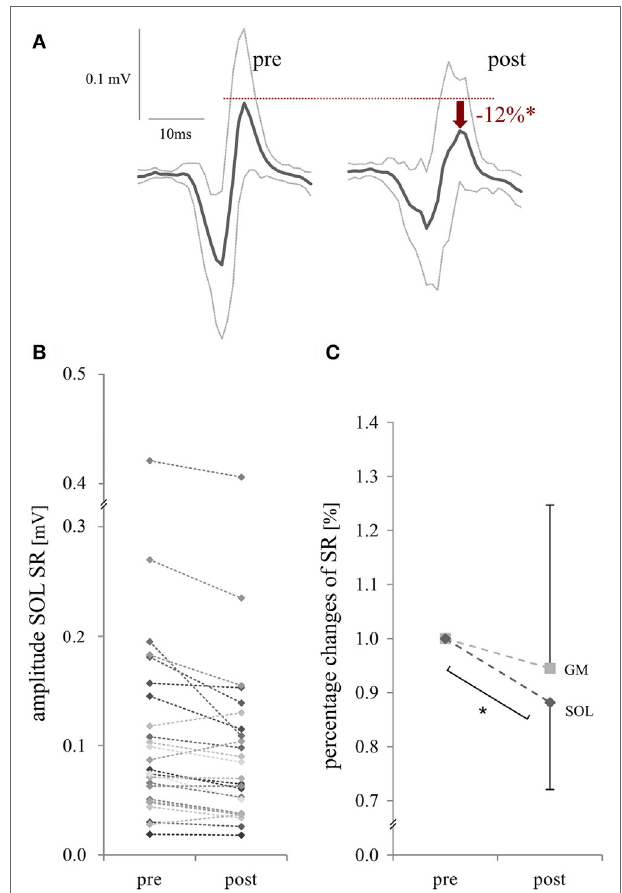
FigUre 3 | Changes in stretch reflex (SR) excitability in the m. triceps surae, induced by mechanical dorsiflexion of the ankle joint ( Protocol 1 ): representative SR amplitude [m. soleus (SOL)] of a single subject (a) , results of each subject [SOL, (B) ] and mean values for SR excitability [SOL and m. gastrocnemius medialis (GM), (c) ] before (pre) and after whole-body vibration (post). (a,B) Raw values of reflex amplitude and (c) percentage changes for the m. triceps surae are presented. Significant changes ( p < 0.05) are illustrated with a *